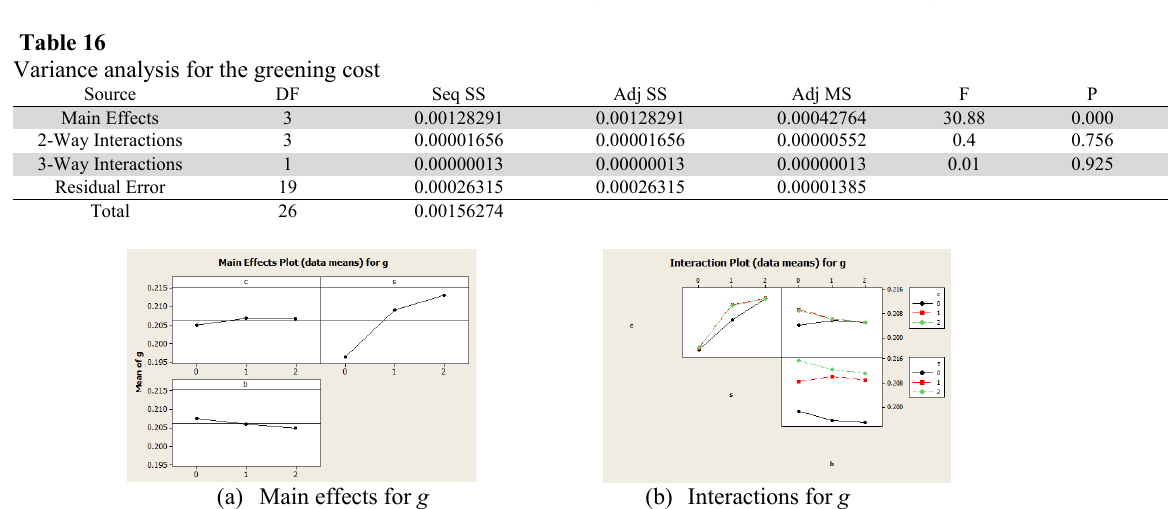
(a) Main effects for g (b) Interactions for g Fig. 6 . Main effects and interactions plot for the greening